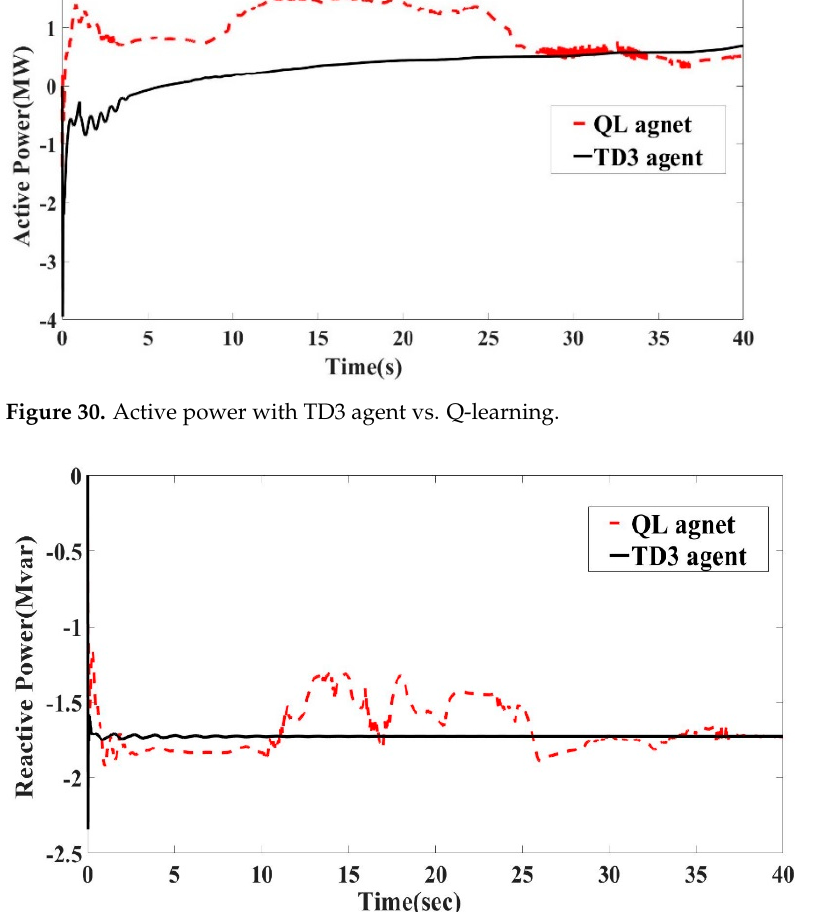
Figure 31 . Reactive power with TD3 agent vs. Q ‐ learning.